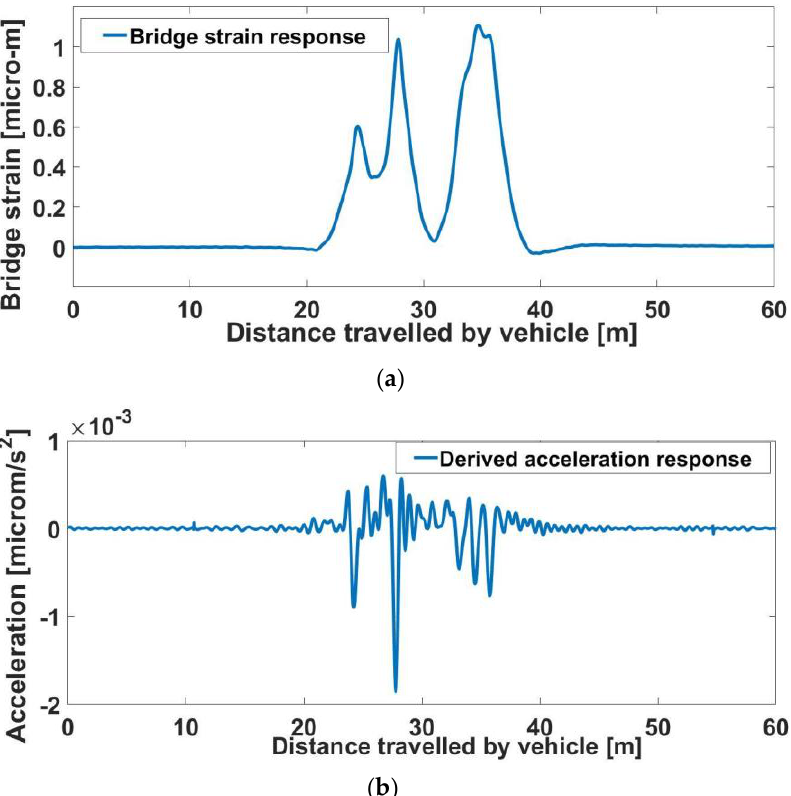
Figure 13. Measured response of the Šentvid bridge to the passage of a typical 5-axle truck: ( a ) Strain; ( b ) Derived acceleration.